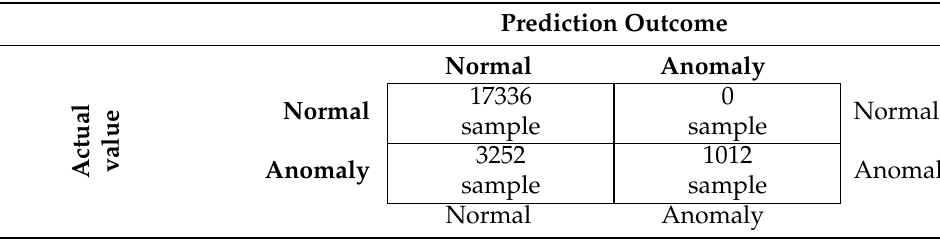
Figure 2. Absolute error in log scale. Table 1. SE performance result for parameter attack detection χ 2 test